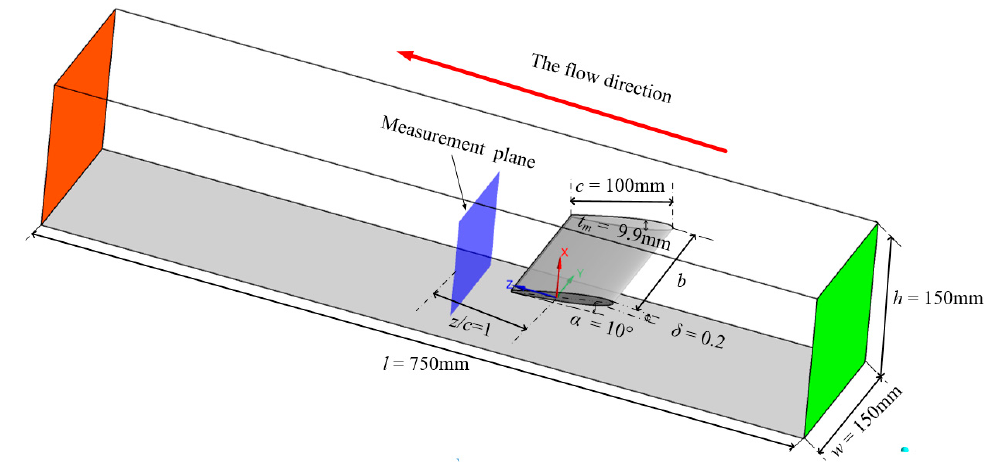
Figure 1. Stereoview with measurement plane.